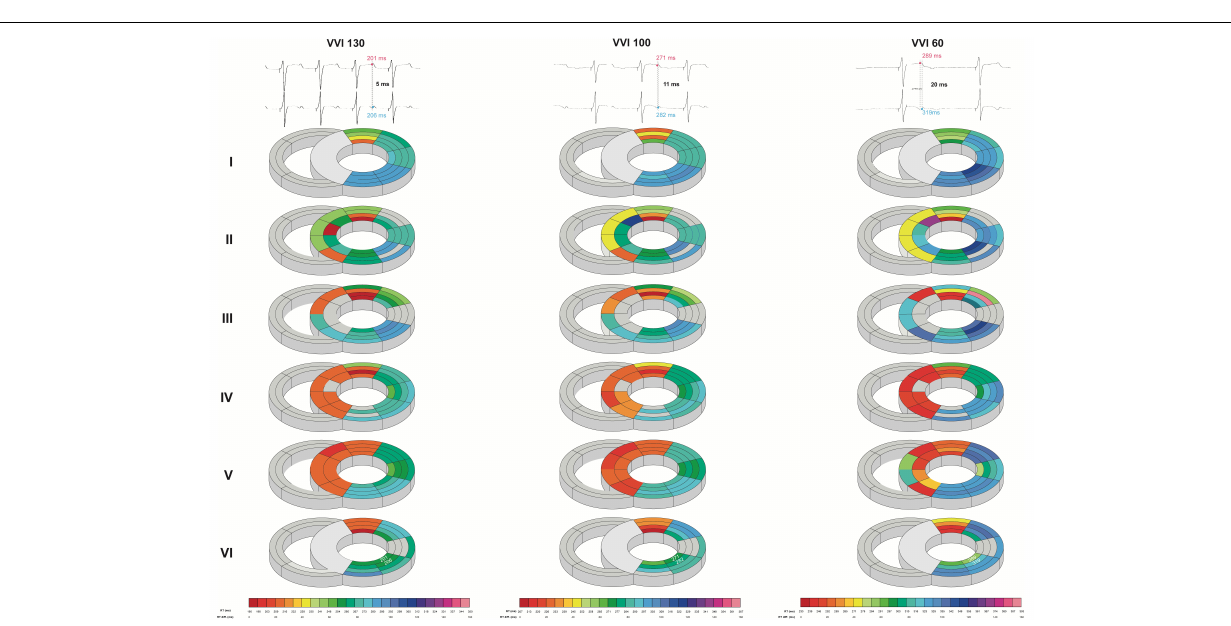
FIGURE 4 | Bradycardia-induced increases in left ventricular intraventricular spatial dispersion of repolarization. Local repolarization times (RT) of one animal during high (130 beats/min), middle (100 beats/min), and experimental (60 beats/min) rate in the septum and LV from base (I) to apex (VI). Traces of two unipolar electrograms with their corresponding RT and their difference herein are depicted to illustrate the evolution of spatial dispersion. Colors and color gradients correspond to the absolute RT and (cid:49) RT values, respectively, as depicted in the color bars below the cardiac